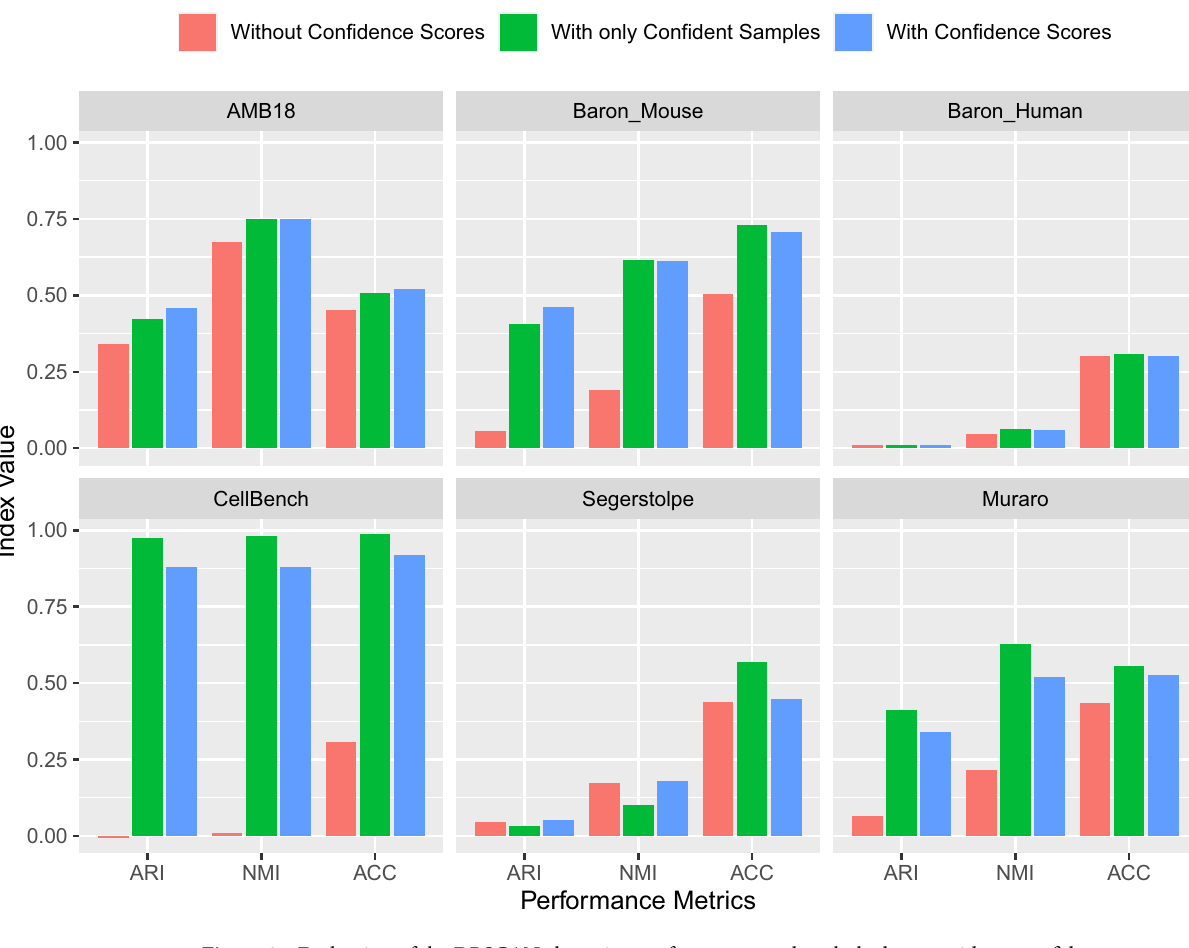
Figure 3. Evaluation of the DBSCAN clustering performance on the whole dataset without confidence scores, on the dataset with only high-confident samples, and on the dataset where the eliminated samples are then positioned on the existing clusters, respectively. The elimination rate is chosen as 0.4. This elimination rate corresponds to the threshold values of confidence scores of 0.985, 0.824, 0.946, 0.859, 0.825, and 0.873 for the datasets,